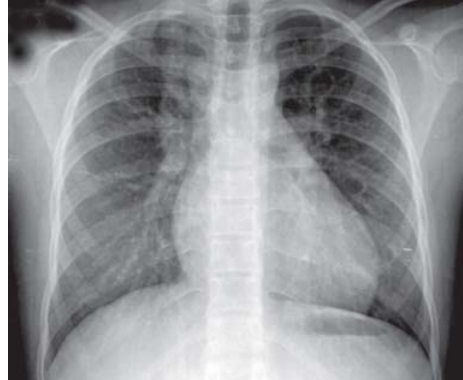
Fig. 2 – Radiografia de tórax sem alterações significativas